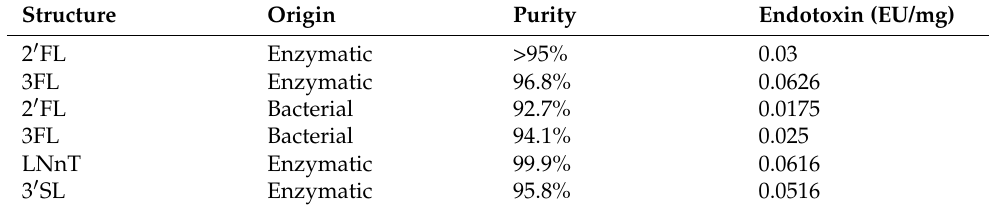
immunomodulatory effects of the HMOS was investigated. The secretion of cytokines from both IEC and PBMCs and phenotype of PBMCs was determined to assess functional immune outcomes.